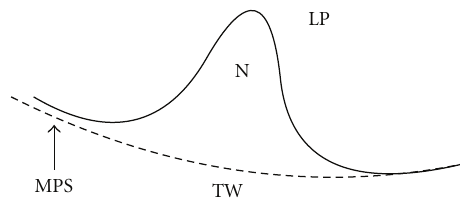
Figure 2: Juxtapleural nodule model, with the modeled pleural surface (MPS) separating the nodule (N) from the thoracic wall (TW). The lung parenchyma in the region indicated by LP.